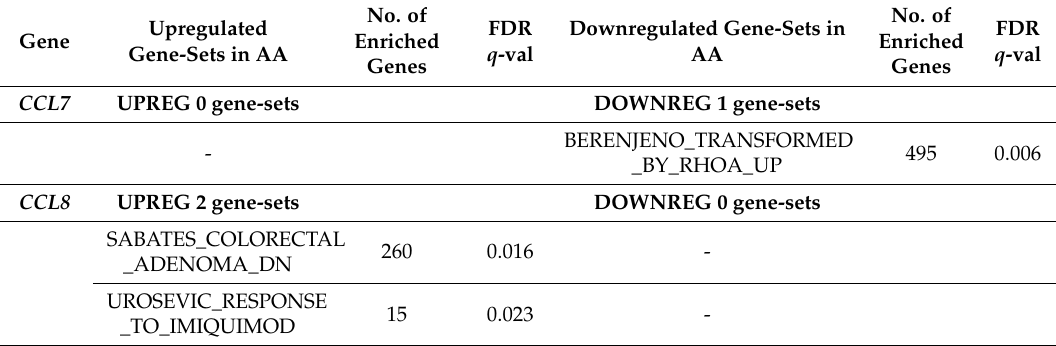
Table 4. Differentially regulated 28 days post-AA gene sets associated with chemokines CCL7 and CCL8 which showed high-fold-change gene expression in the distal colon three days